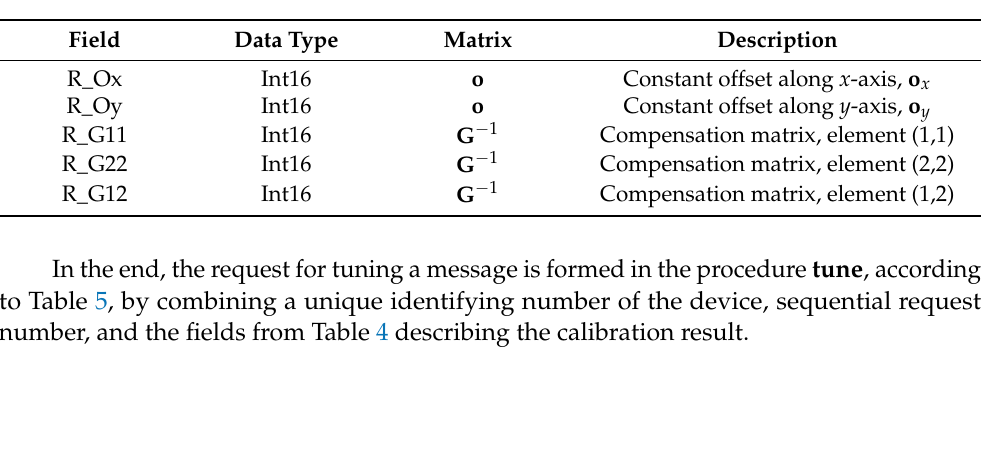
Table 4. Calibration